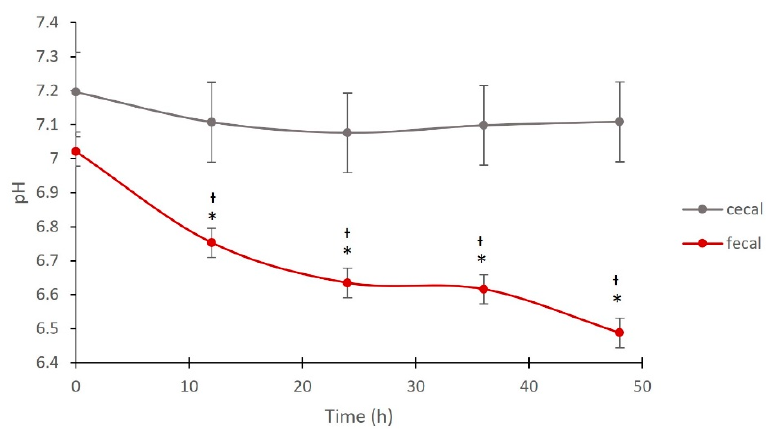
Figure 1. Comparison of pH between cecal and fecal vessels maintained in an anaerobic chamber. pH of cecal and fecal inocula maintained in an anaerobic chamber at 12 h intervals following vessel establishment (0 h). To inoculate 100 mL vessels, 100 ml of cecal fluid (anaerobic cecal, n = 15) or 5% fecal slurry (anaerobic fecal, n = 6) was used; * represents a significant difference between a timepoint and 0 h within a fermentation method ( p < 0.05); ᵻ represents a significant difference between methods at a particular timepoint ( p < 0.05).